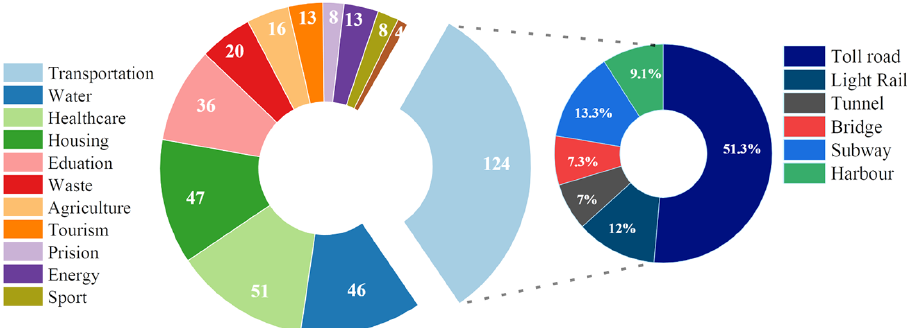
Figure 3. Summary of fields applied to PPP